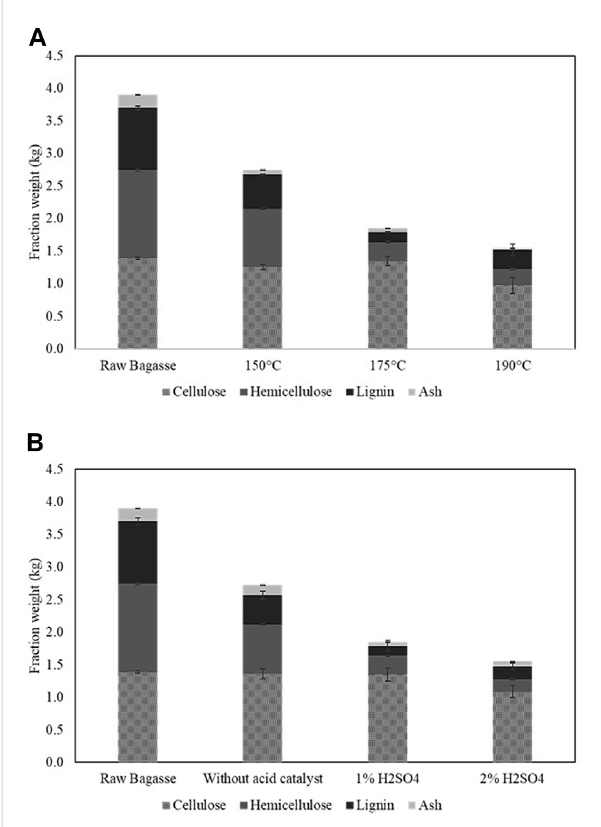
FIGURE 2 Compositionofbagassebeforeandafterethanosolvfractionated at various temperatures (1%H 2 SO 4 ,60 min) (A) and at various H 2 SO 4 concentration (175 ° C, 60 min) (B)